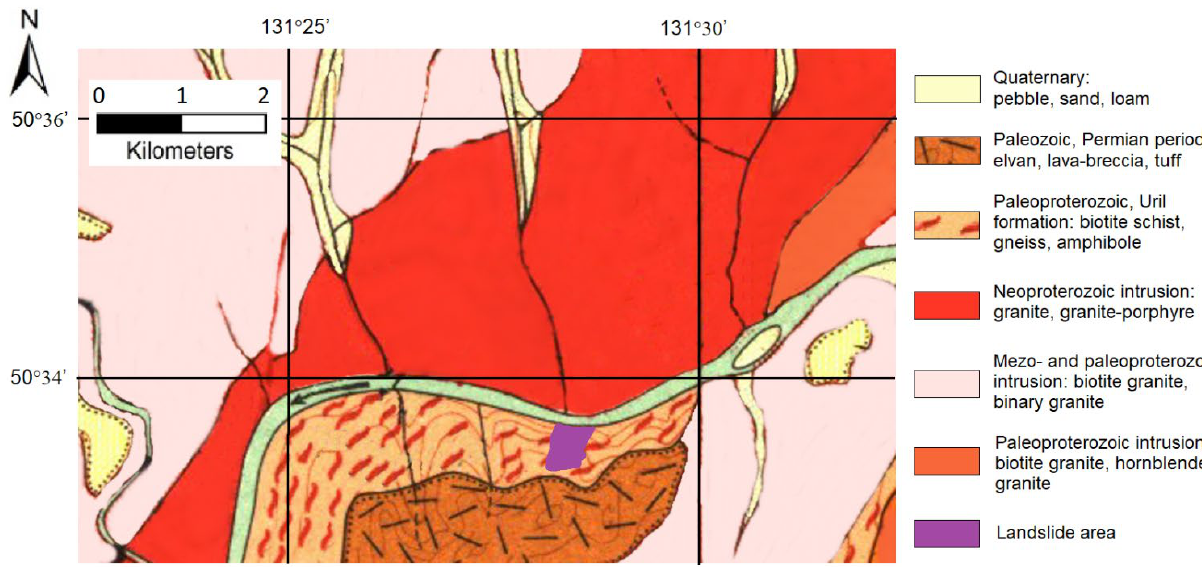
Figure 2. Geological description of the territory around the landslide area.